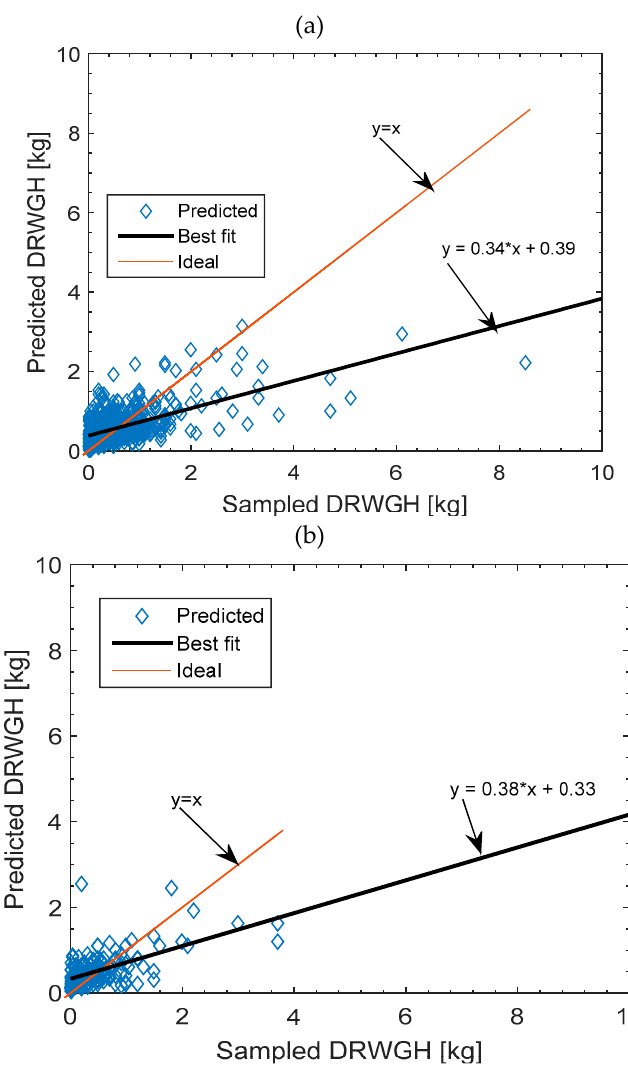
Figure 4. The graphical depiction of results of training and testing for recyclable composition. ( a ) Training and ( b ) testing. DRWGH means Daily Recyclable Waste Generated from Households.